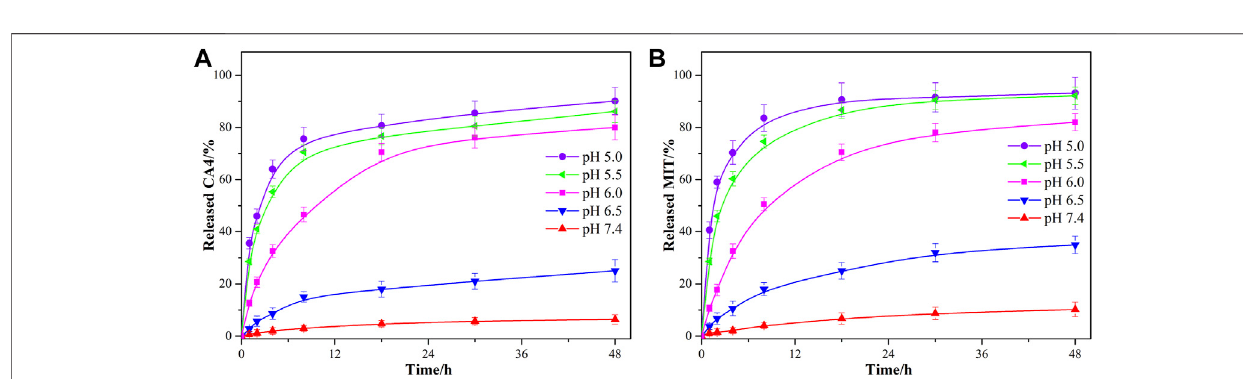
FIGURE 4 | The CA4 (A) and MIT (B) release pro fi les of CMMOPs at pH 5.0, 5.5, 6.0, 6.5, and